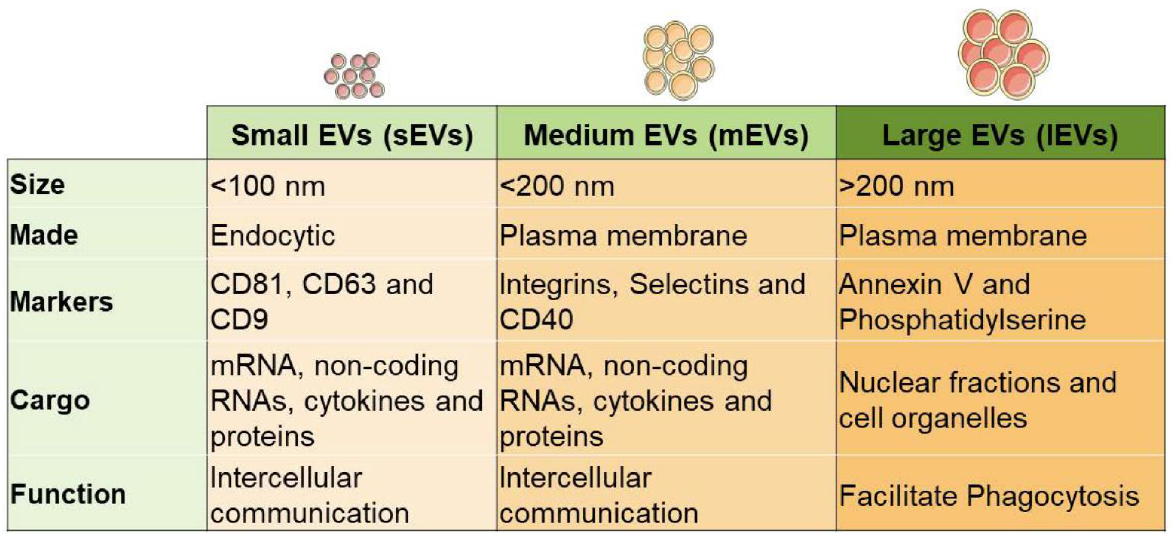
Figure 3. Schematic diagram of EV sources and their use in therapeutic and biomarker applica- tions. Reprinted from [18]. 2. Source of Stem Cell Extracellular Vesicles (Figure 4) 2.1. Bone Marrow Mesenchymal Stem Cell-Derived EVs Stem cells derived from bone marrow (BM) have long been utilized clinically to treat various hematopoietic malignancies. However, it has now been shown that even their EVs alone may hold therapeutic application. For example, BM-MSC-EVs have been found to be released under conditions of hypoxia to promote neoangiogenesis in vitro and in vivo [19]. This is consistent with the finding that they increase cancer cell survival under stress and support breast tumor growth in vivo [20]. There is evidence that these